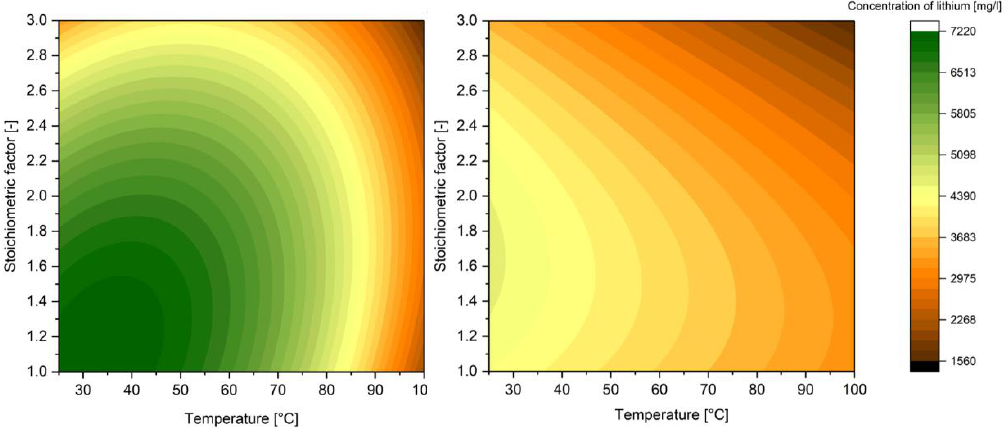
Figure 2. Statistical evaluation of the dissolved residual concentrations in mg · L − 1 of lithium starting from the synthetic ( left , 10,000 mg · L − 1 ) and authentic ( right , 5000 mg · L − 1 ) leaching solution using the precipitant K 2 HPO 4 as a function of temperature and the stoichiometric factor of the precipitant.